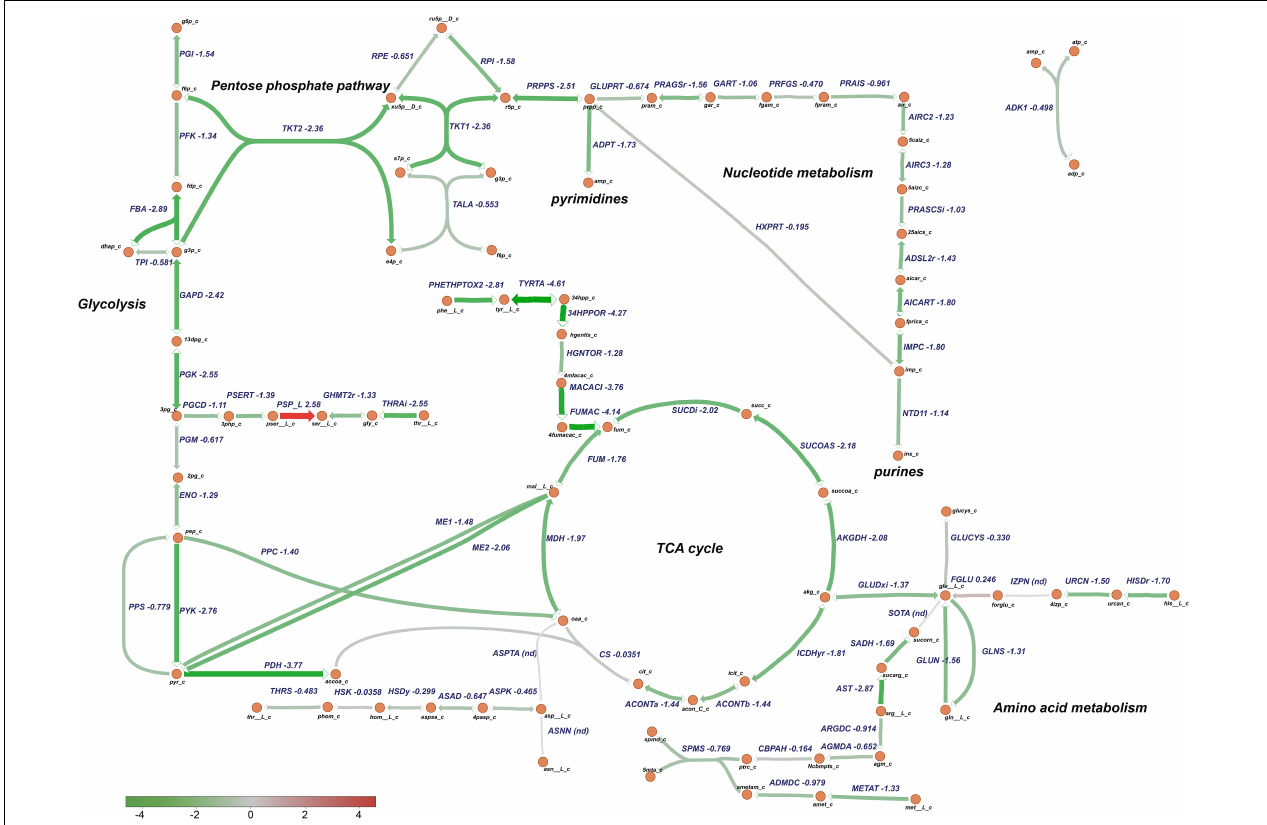
FIGURE 9 | Downregulation of central metabolic pathways in P. salmonis growing in CMMAB with amp. Genes differentially expressed between P. salmonis grown in the CMMAB amp medium and the Austral-SRS medium were mapped to glycolysis, the TCA cycle, pentose phosphate pathway, nucleotide, and amino acid metabolism using the genome-scale model iPS584 for this pathogen. Expression levels are shown as log 2 fold-change values; downregulated genes are in green and upregulated genes are in